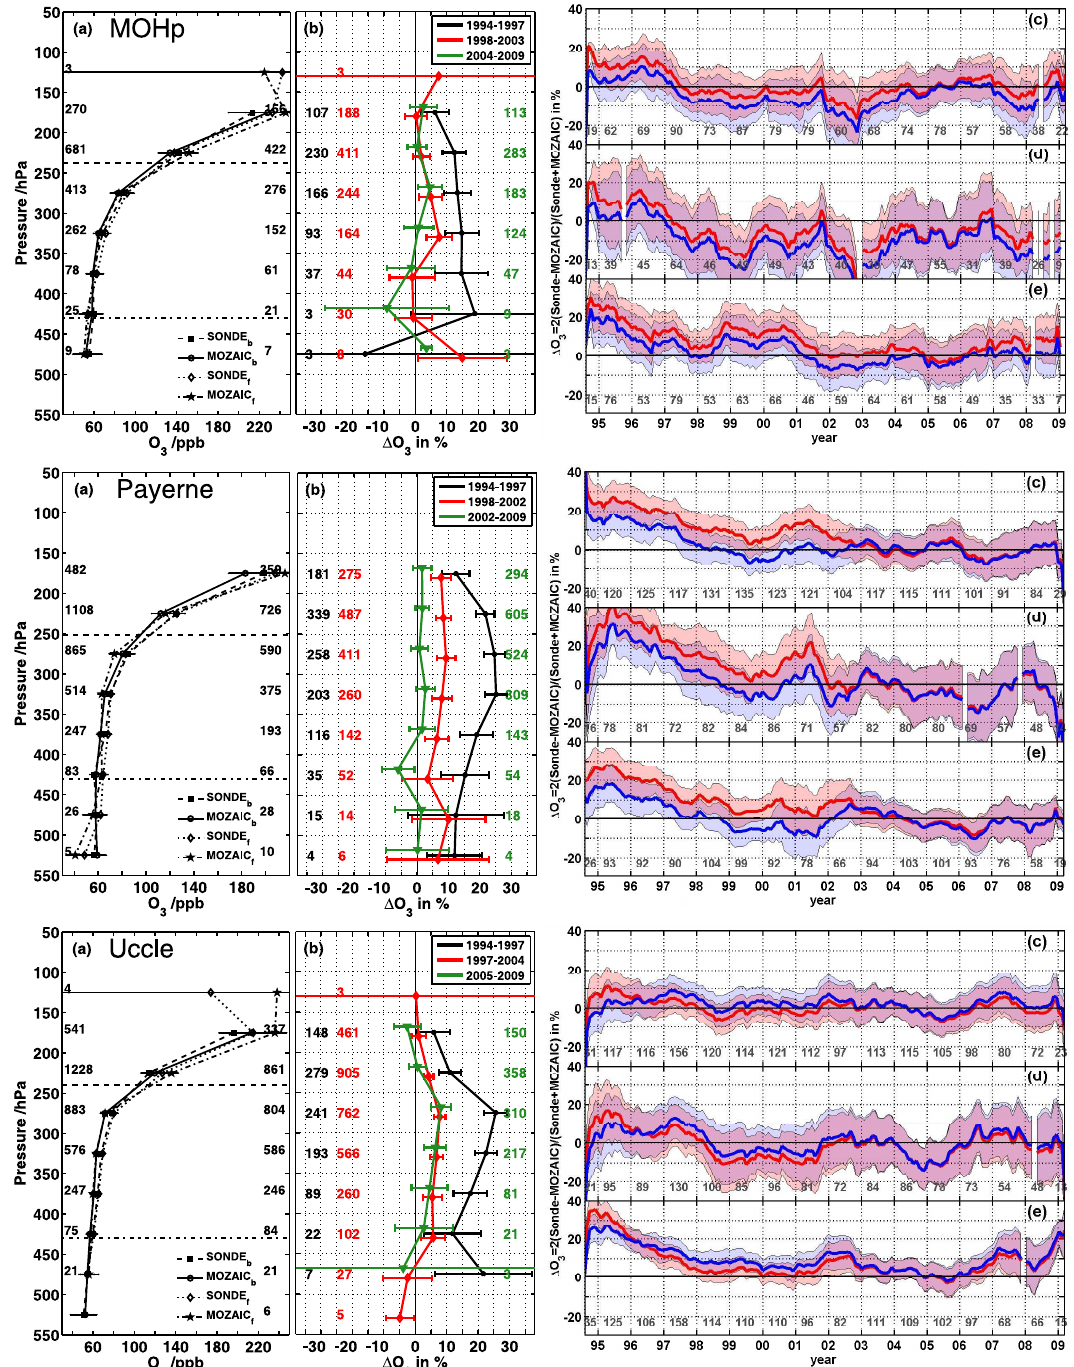
39 Fig. 3. Comparison between MOZAIC O 3 measurements and ozonesondes from MOHp, Payerne, and Uccle. (a) 16 yr average O 3 profiles from sonde and MOZAIC binned into 50hPa layers. Numbers on the left and right denote the number of soundings using 6day backward-only and forward-only trajectories, respectively. The dashed horizontal line denotes the tropopause, the dash-dotted horizontal line the level up to which Logan et al. (2012) compared ozonesondes with MOZAIC. (b) Relative differences 1 O 3 = 2 ( sonde − MOZAIC )/( sonde + MOZAIC ) split into three periods. The number of sondes available for comparison is displayed for each period on the sides. Time series of 1 O 3 with CF (red) and without CF (blue) are displayed for the LS (c) , a narrow tropopause band (d) , and the UT (e) . Numbers at the bottom indicate the number of soundings used for calculating monthly mean differences. The error bars in panels (a) and (b) denote the 90% confidence of the median, while in (c) – (e) the shaded areas denote the standard error (68% confidence). Overlapping areas are displayed in light